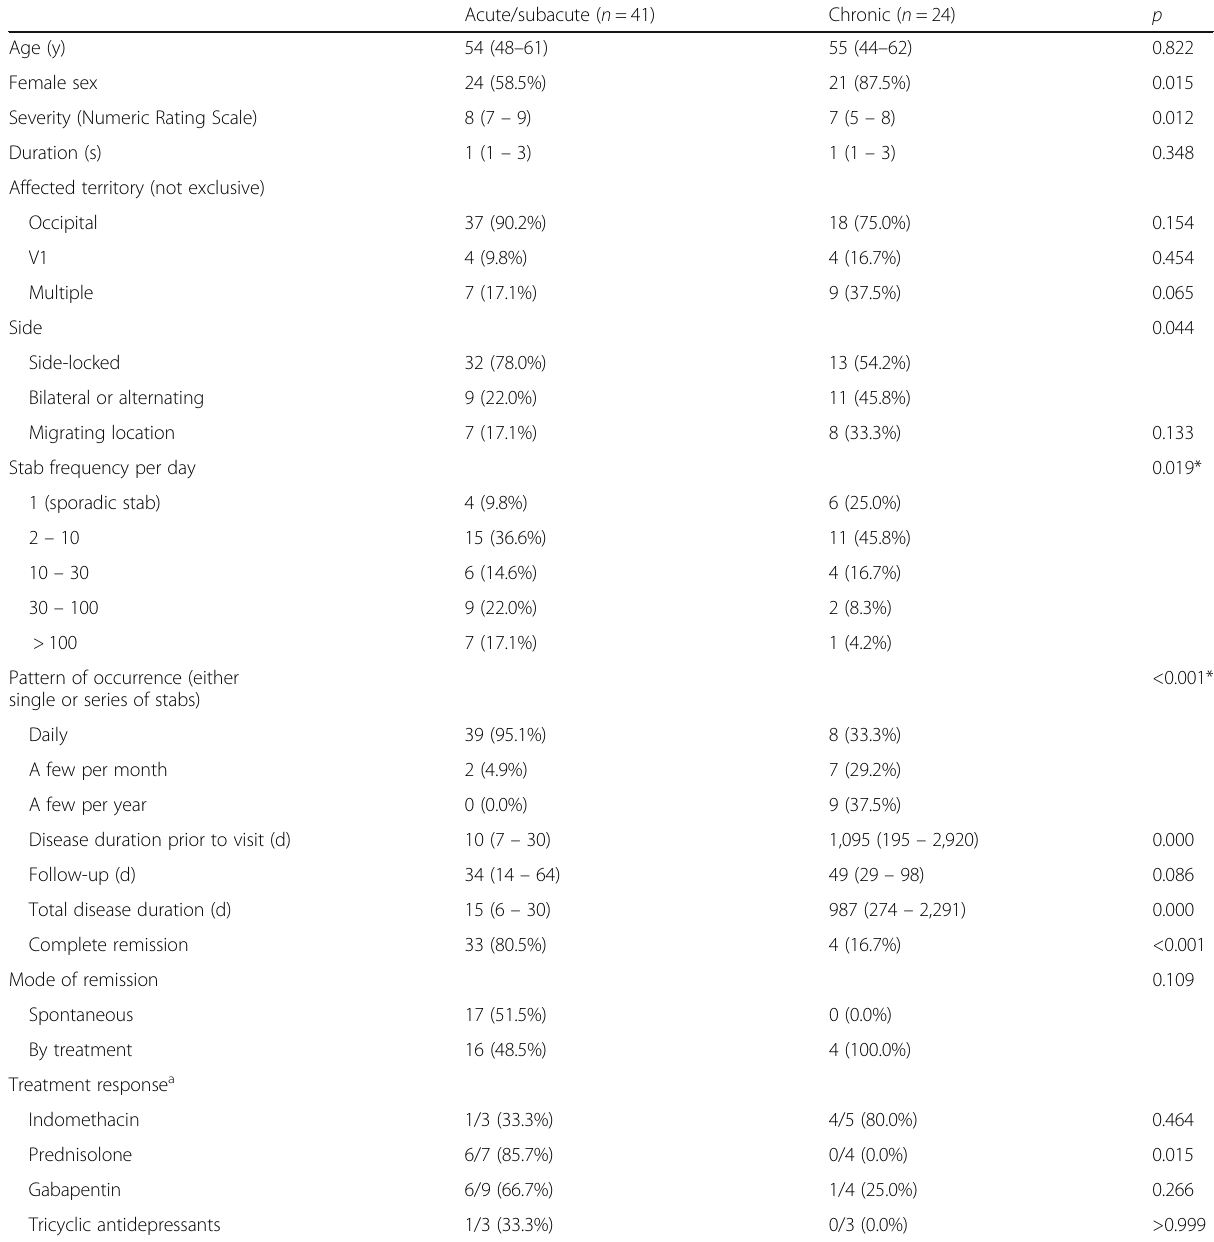
Table 2 Patient demographics and characteristics according to chronicity at the initial